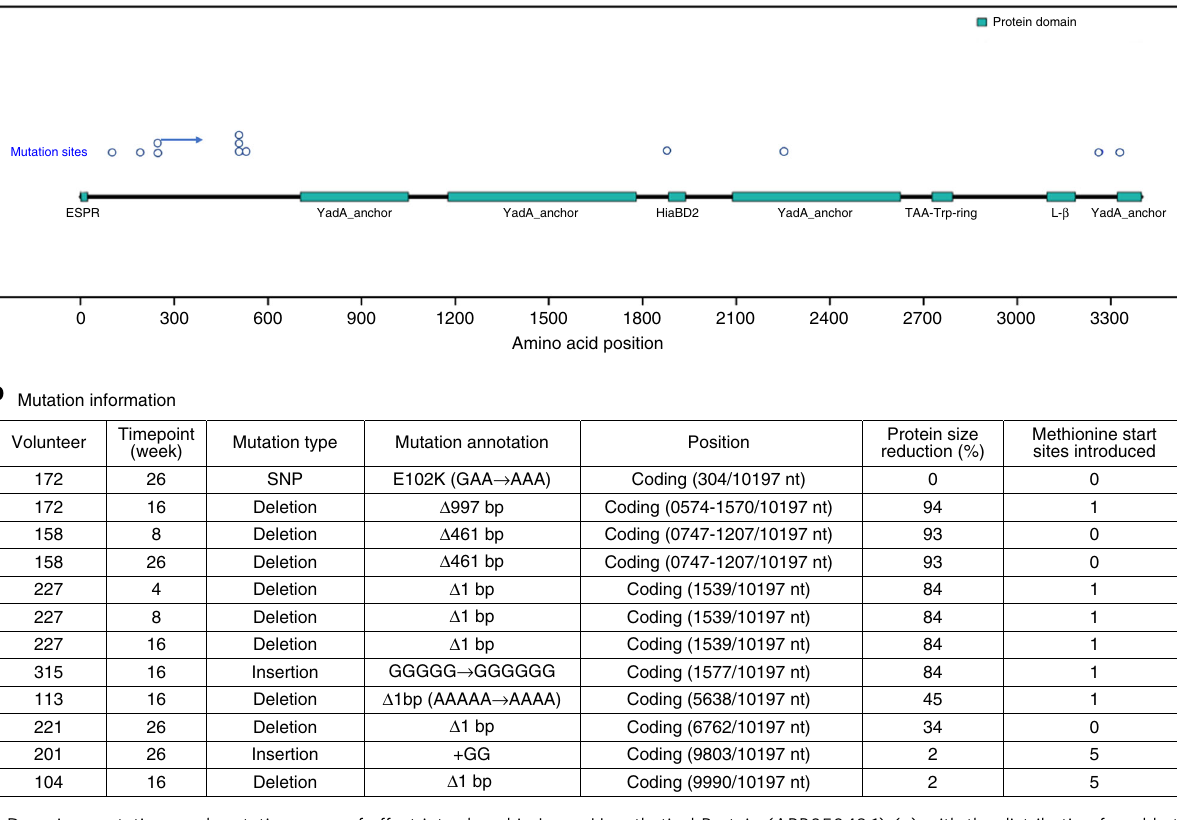
Fig. 2 Domains, mutations and mutation areas of effect introduced in Large-Hypothetical Protein (ARB05049.1) ( a ) with the distribution found between volunteers ( b ). Mutations are coloured blue and white and are listed in b in the order they occur along the protein depicted in a